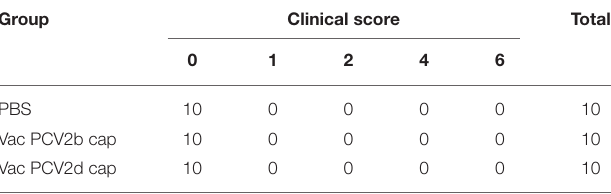
TABLE 4 | The clinical symptoms of the mice are scored. Group Clinical score Total